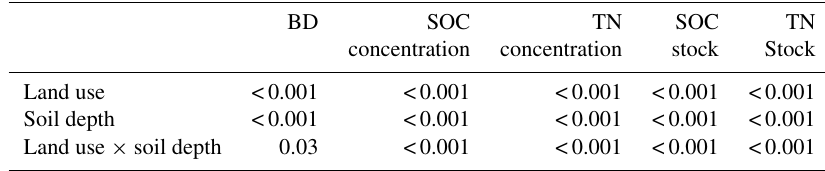
Table 3. Results ( P values) of two-way ANOVAs on the effects of land-use types, soil depth and their interaction on soil bulk density (BD), soil organic C (SOC) and total nitrogen (TN) concentrations and stocks.